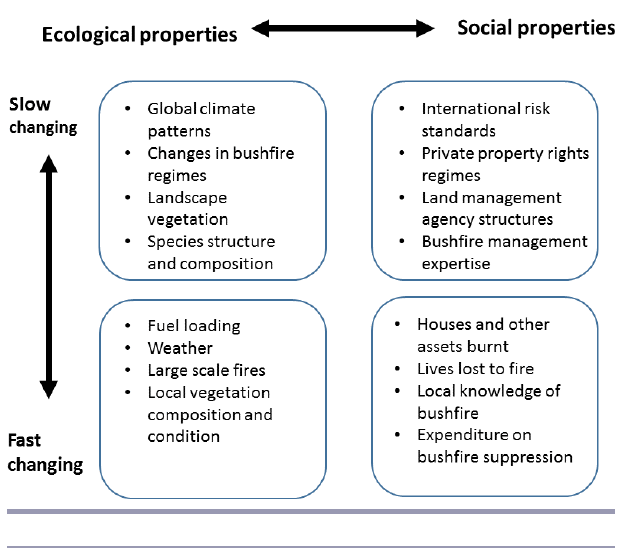
Fig. 1. Examples of components of a bushfire management SES. Fast- and slow-changing ecological and social properties can be observed acting and interacting in different combinations at multiple scales (adapted from Steelman 2016).